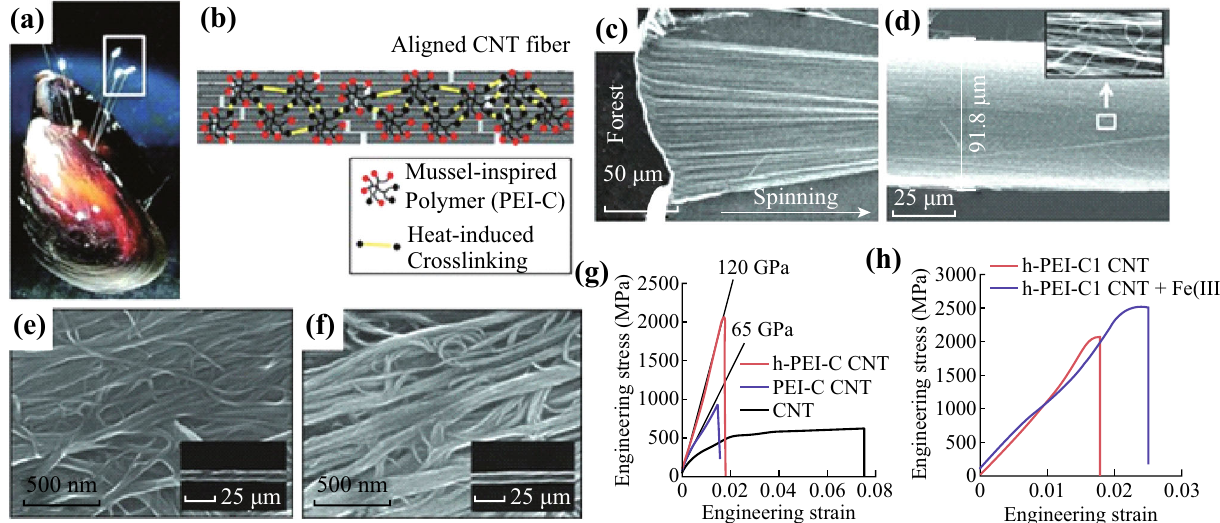
Fig. 14 a Photograph of a mussel attached to Si substrate. b A schematic illustration of one-dimensionally aligned CFs reinforced by mussel- mimetic adhesives. SEM observations of fiber spinning process c and the spun CFs ( d ). High-magnification SEM images of the densified CF e and h-PEI-C treated CF f . Mechanical curves of the CFs. ( g , h ) Stress–strain curves of h-PEI-C-CNT ( red ) and h-PEI-C-CNT ? Fe(III) ( blue ). Reproduced with permission from Ref. [80]. Copyright 2011, Wiley–VCH. (Color figure